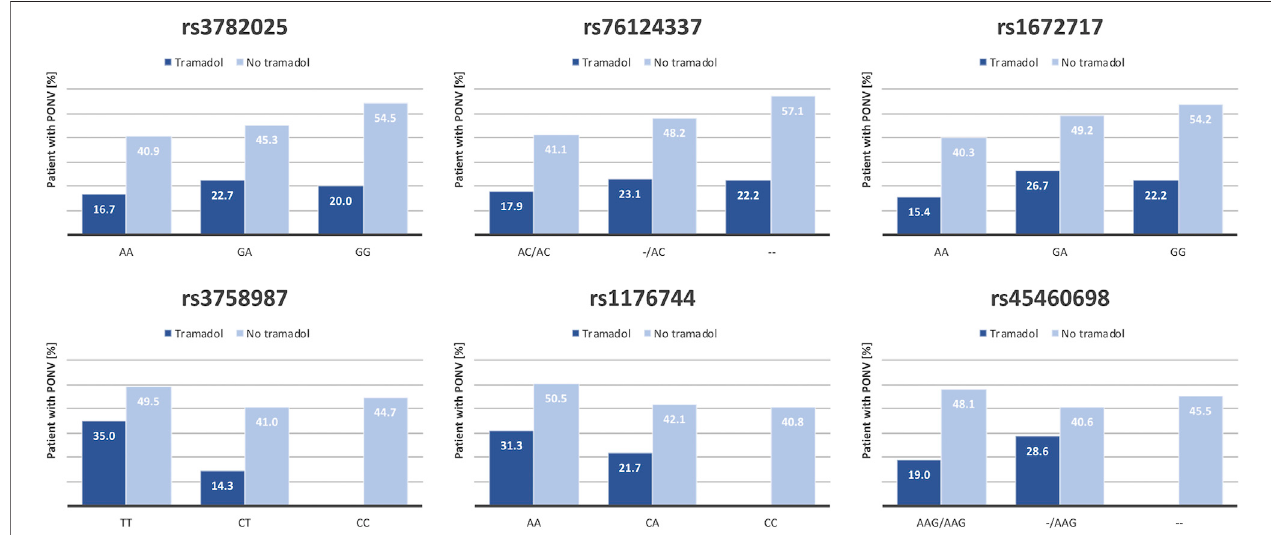
FIGURE 3 | Effect of tramadol on association between HTR3B -related polymorphisms and PONV occurrence. Tramadol is a selective serotonin reuptake inhibitor that could in fl uence 5-HTR 3 receptor function and thus modulate the effect of HTR3B polymorphisms on PONV occurrence. The fi gure shows the proportion (%) of patients suffering from PONV in function of tramadol administration in each genotypic category for each of the six HTR3B SNP tested.